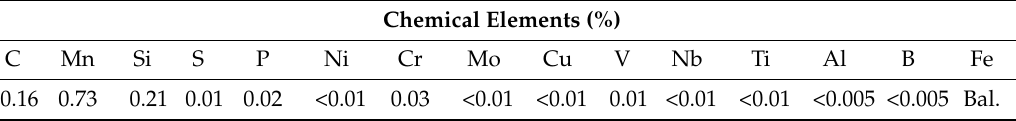
Table 2. Steel components determined by optical emission spectroscopy. Chemical Elements (%)